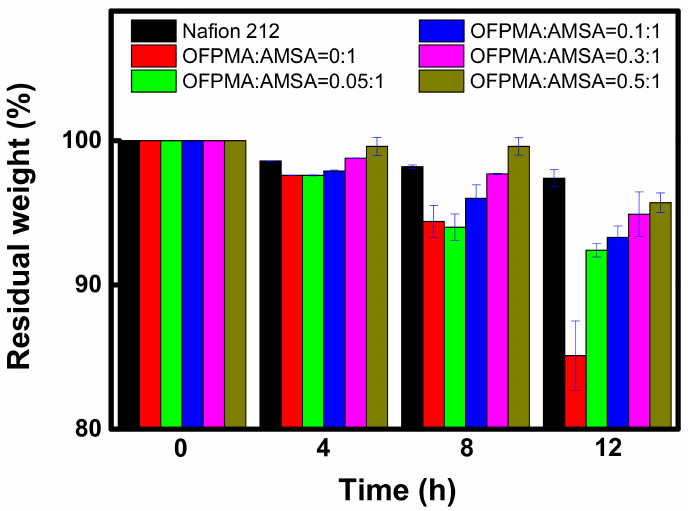
Figure 7. Time-course change in the residual weight of commercial and prepared PFPEMs during the Fenton oxidation test.